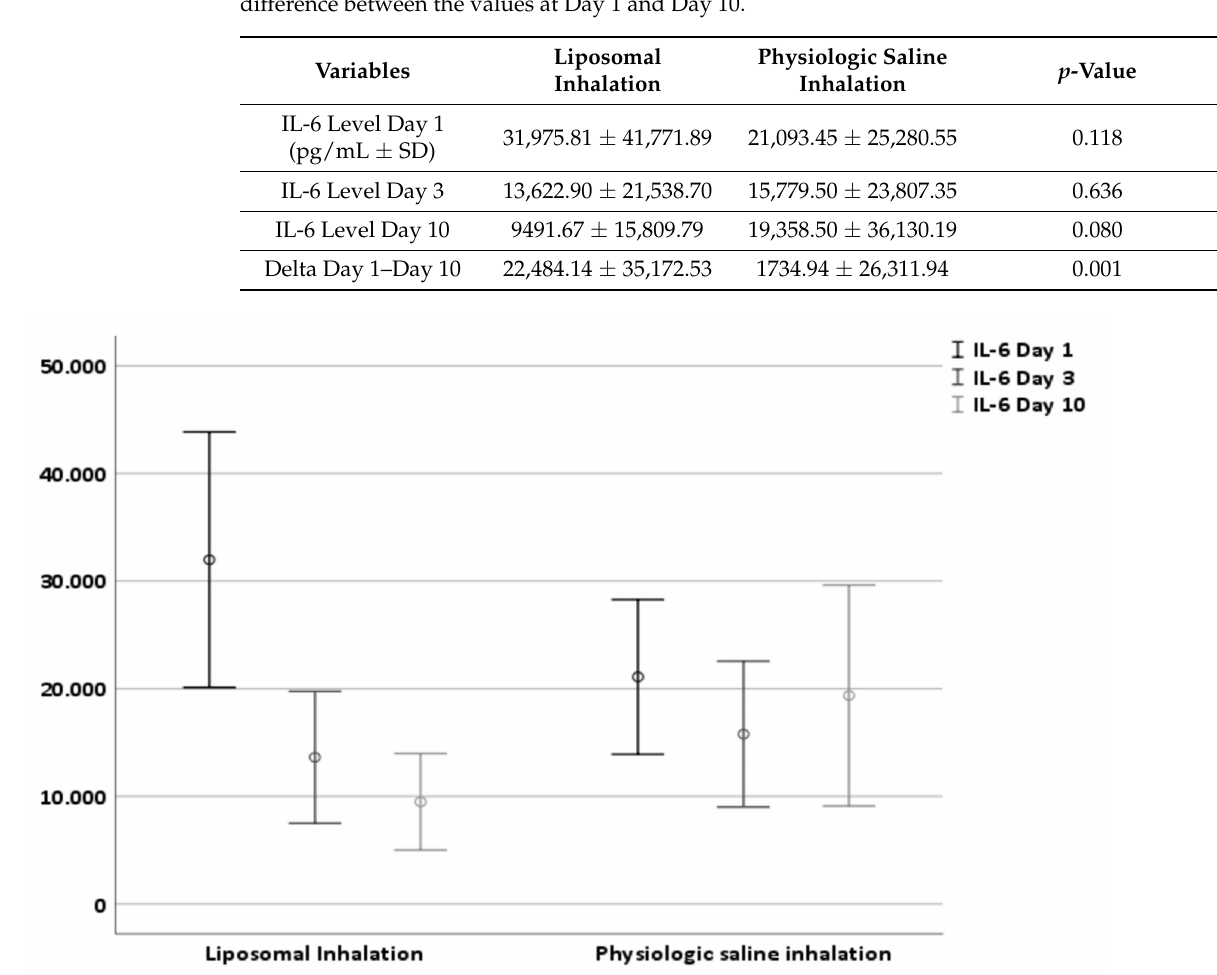
Table 2. Interleukin-6 levels at Day 1, Day 3 and Day 10 after tracheostomy, Delta Day 1–Day 10: